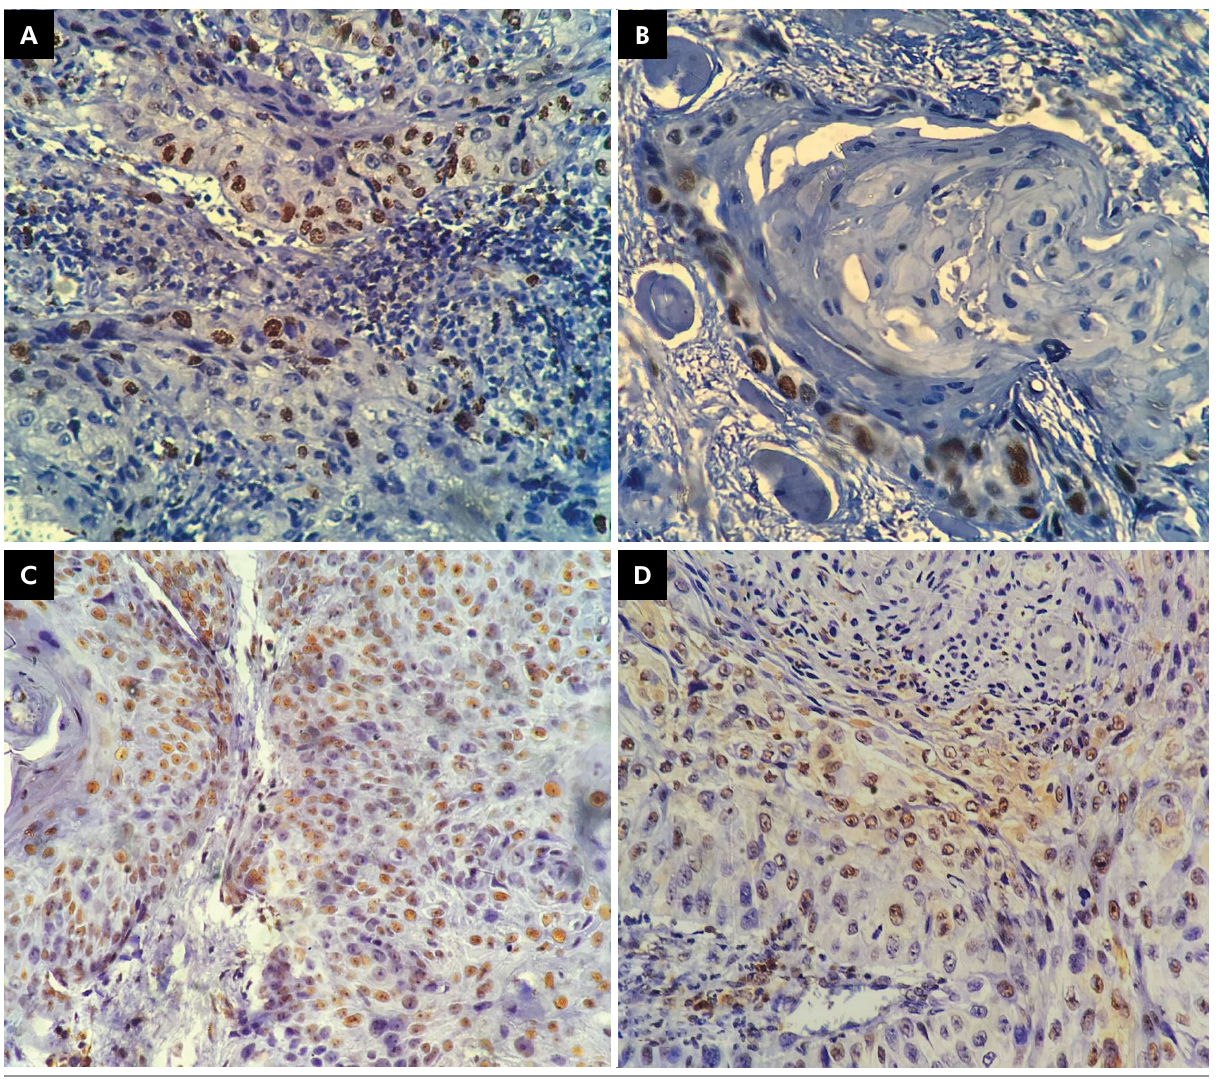
Figure 1. Immunoexpression of Ki-67 in OSCC epithelium (A). Strong immunostaining for Ki-67 in tumor strands and in tumor islands (B). Immunoexpression of MCM3 in OSCC epithelium (C). Moderate immunostaing for MCM3 in the nucleus